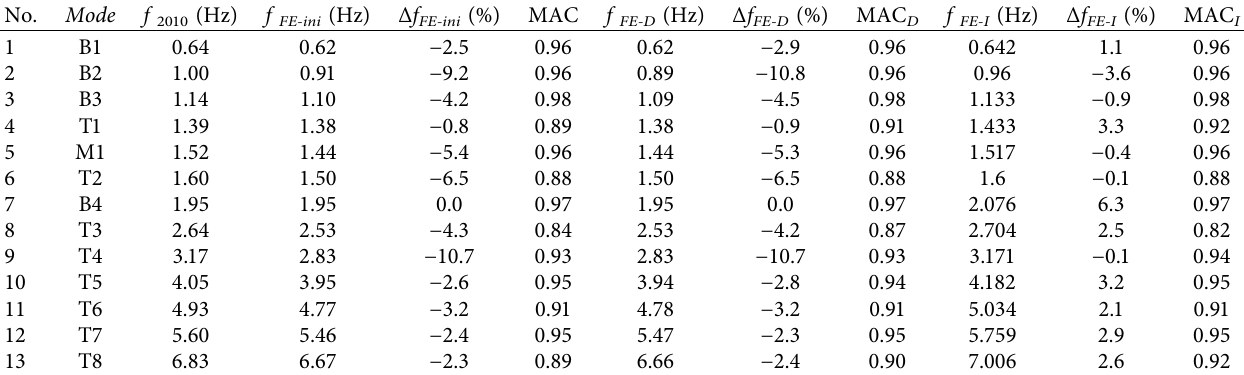
Table 7: Comparison of the experimental and numerical data for the updated FE models with two parameters. No. Mode